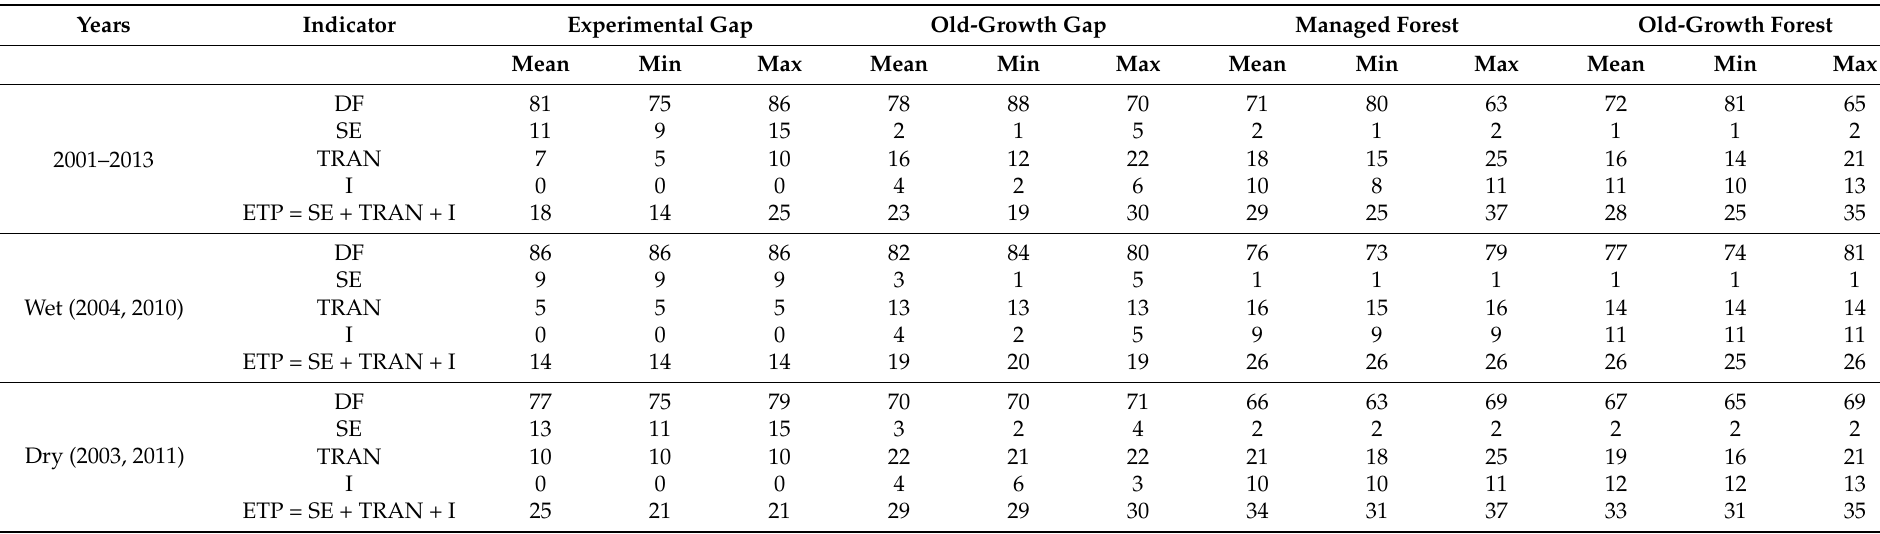
Table 2. Median, minimum, and maximum annual canopy interception (I), transpiration (TRAN), soil evaporation (SE) and drainage flux (DF) as % of precipitation in the open (P) for the gaps and forests in the Dinaric Karst from 2001 to 2013 (for the old-growth gap from 2003 to 2013) and separately in wet years (2004, 2010), and dry years (2003, 2011).